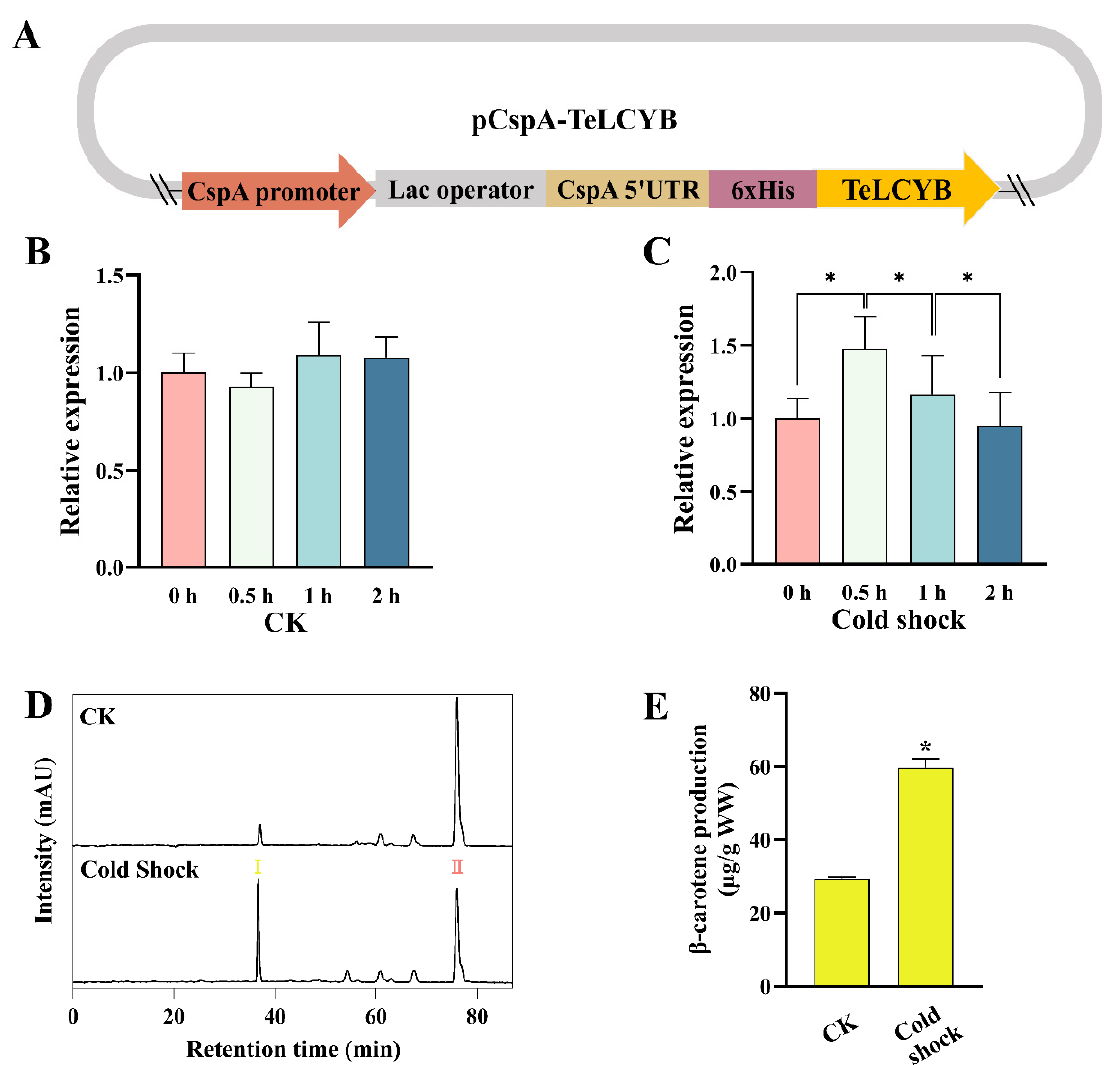
Figure 4. Activation of TeLCYB by CspA promoter under cold shock treatment in lycopene-accumulating E. coli . ( A ) The fusion structure of pCspA-TeLCYB expression vector with N-terminal CspA promoter, lac operator, CspA-5’UTR, and 6xHis tag. ( B , C ) The relative expression profiles of TeLCYB without ( B ) or with ( C ) cold shock treatment in two hours. ( D ) HPLC spectra of XL-1 Blue strains harboring pAC-LYC and pCspA-TeLCYB with or without cold shock treatment. I, β -carotene; II, lycopene. ( E ) β -carotene-accumulation patterns in XL-1 Blue strains harboring pAC-LYC and pCspA-TeLCYB with or without cold shock treatment. (*) p <